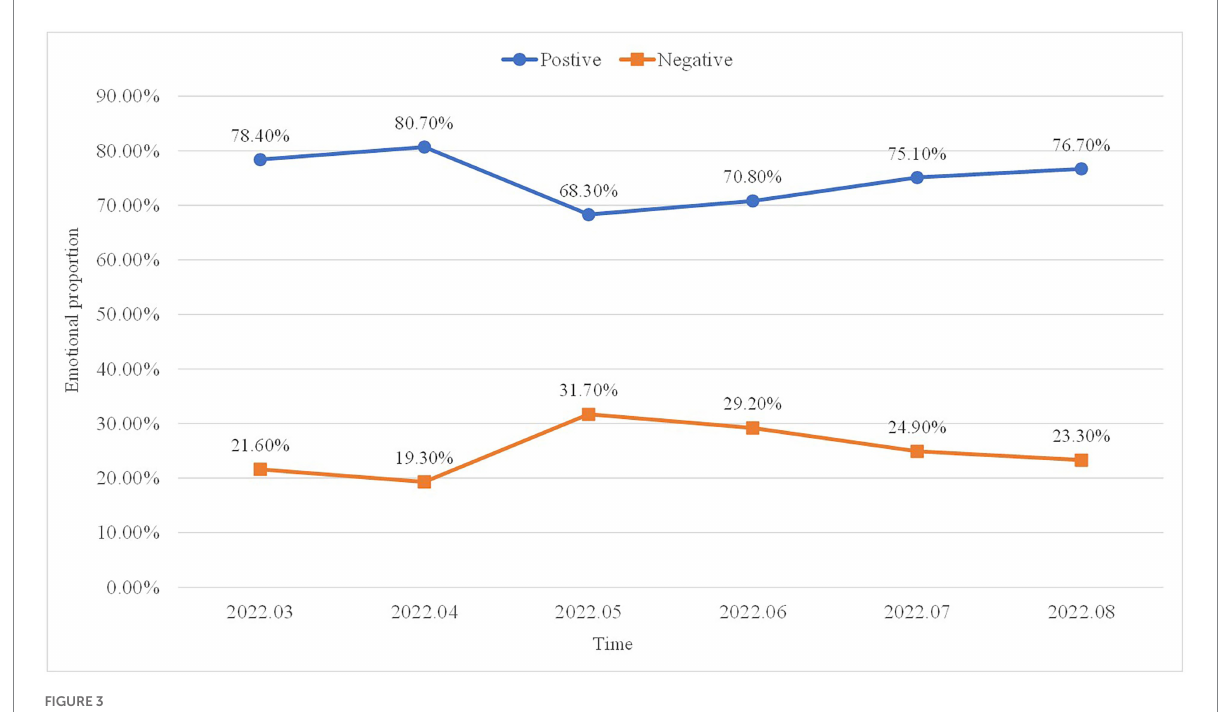
FIGURE 3 Variations in sentiment values from March 2022 to August